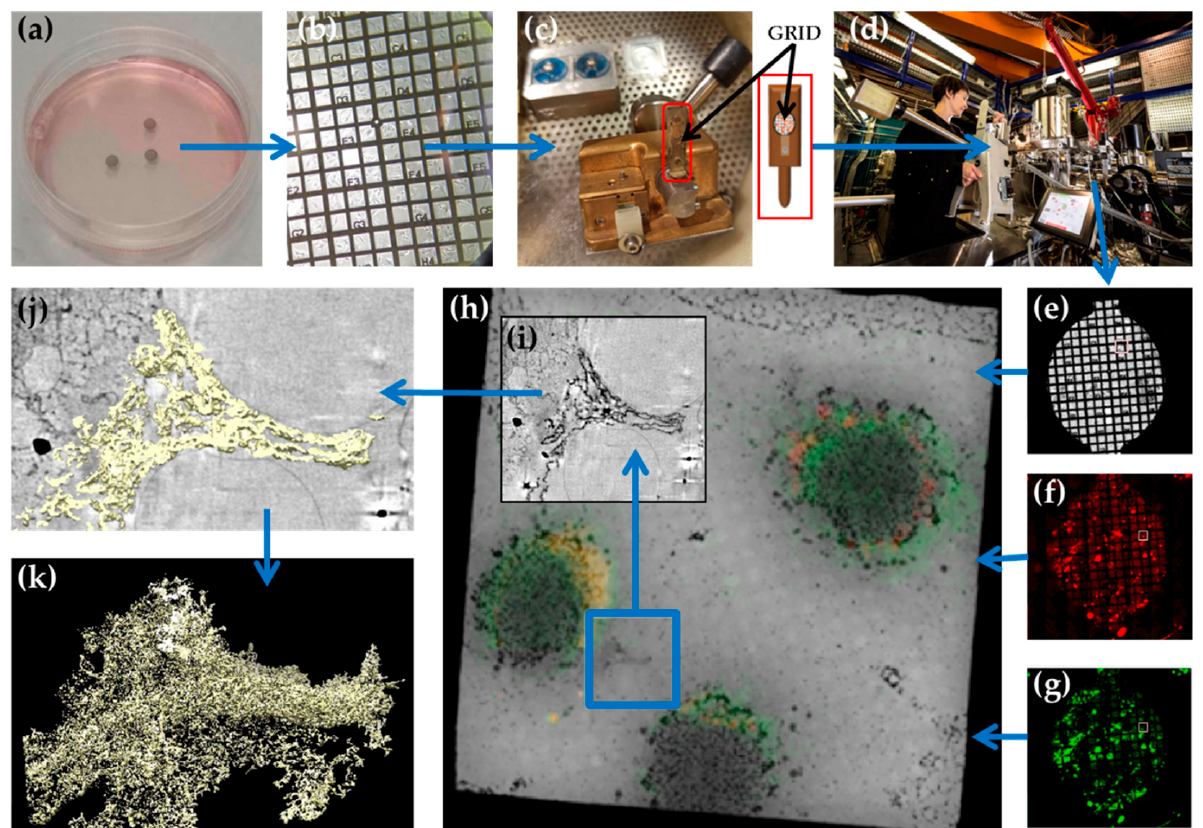
Figure 1. Workflow followed in cryo-SXT. ( a ) P60 Petri dish with 3 grids on which cells were seeded. ( b ) Close-up view of cells grown on top of a grid, 24 h after seeding. ( c ) Workstation with the grid sample holder inserted into the loader. In the picture, the grid is already loaded into the grid sample holder (red box). A schematic drawing of a sample holder is shown on the right. The position of the loaded grid is also indicated. ( d ) Attachment of the transfer chamber to the transmission X-ray microscope (TXM). ( e – g ) Mosaics of the grid acquired with visible light ( e ), red fluorescence ( f ), and green fluorescence ( g ). ( h ) 2D X-ray mosaic of a grid square, superposed with the correlated red and green fluorescence mosaics, showing the positions of 3 cells. ( i ) Slice from the reconstructed 3D volume corresponding to the area marked with the white box in ( h ). ( j ) Manual segmentation of the surface boundaries identifying a polysome organelle present in the cell. ( k ) Manual segmentation of the organelle in ( j ). Panels ( a ) to ( d ) adapted from Groen et al. 2021 [24], with permission from JoVE)